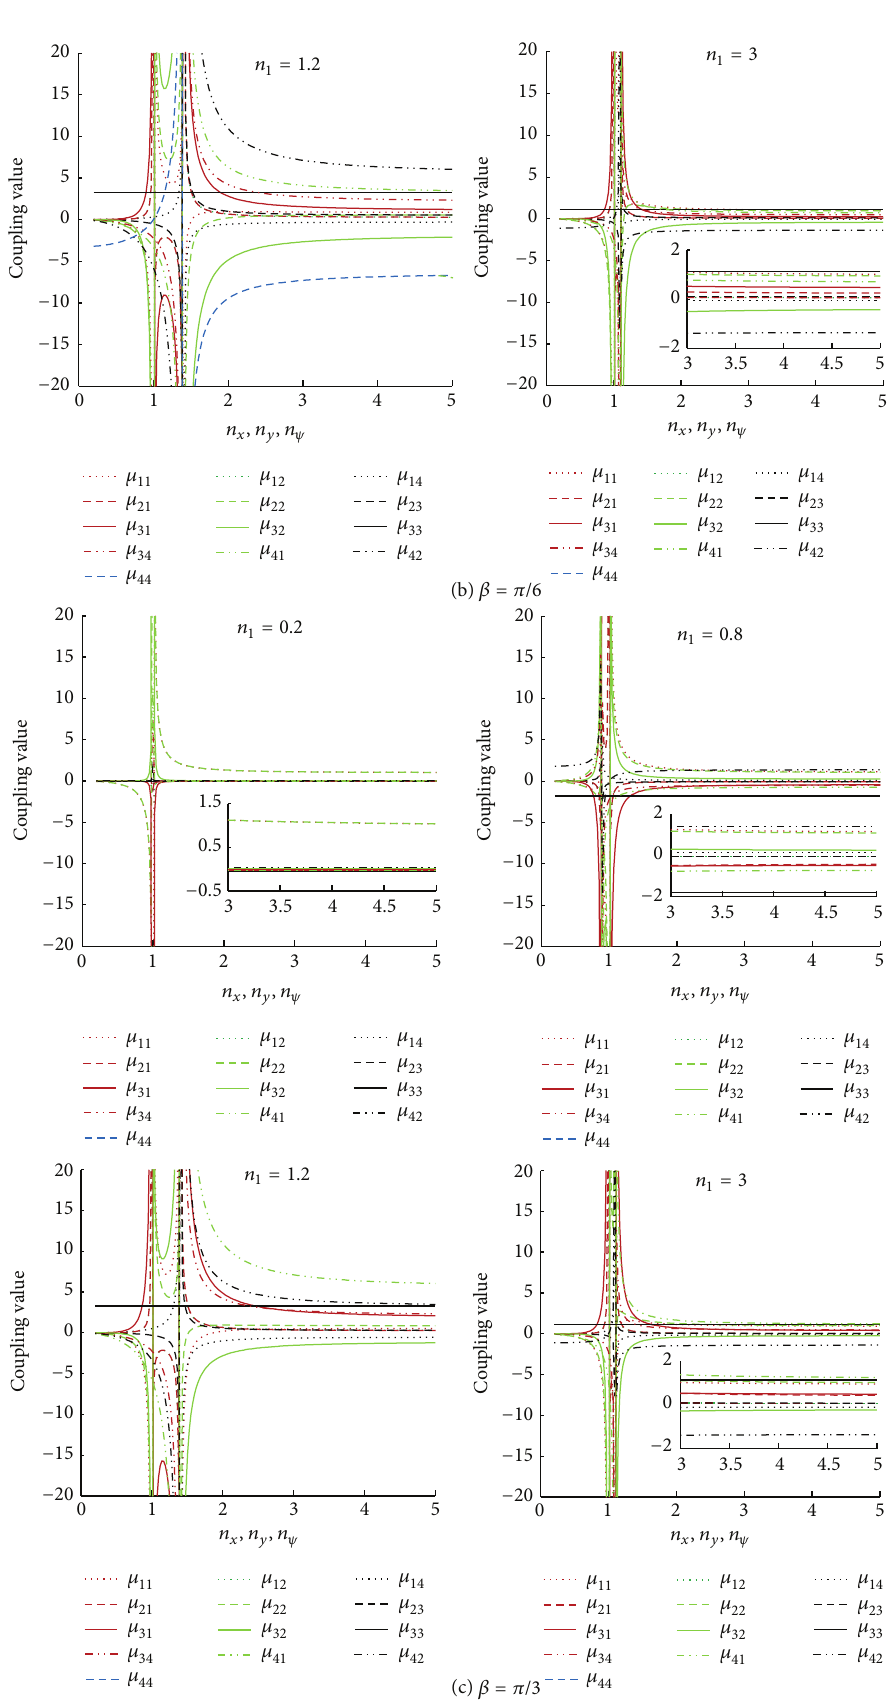
Figure 2: The value of the coupling coefficients of the system for 𝜂 13 = 5 , 𝜂 23 = 1 , 𝑟 𝑚 = 0.025 , 𝑙 = 0.6 , and 𝑟 𝑜 = 2 considering the difference of angular 𝛽